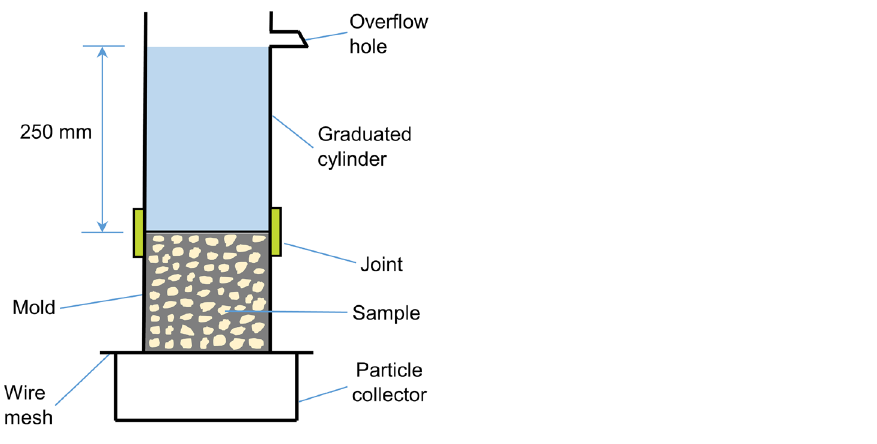
Figure 1. Falling head apparatus for permeability test.